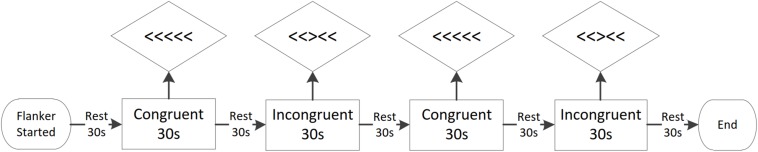
The full Flanker task consists of four blocks of 30 trials each, which include two congruent flanker tasks and two incongruent flanker tasks. The stimuli are randomly presented in the center of the computer screen. The stimuli include congruent flanker conditions (e.g., > > > > > and < < < < <) and incongruent flanker conditions (e.g., > > < > > and < < > < <) conditions. Each block has a 30 s rest period.